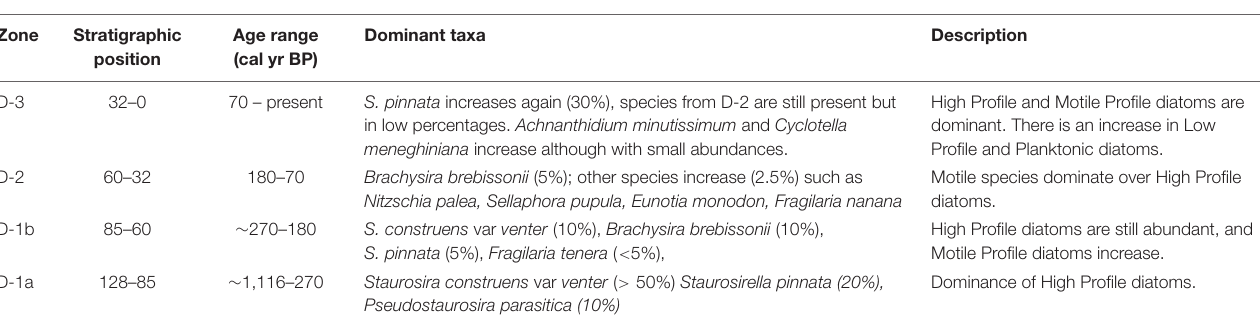
FIGURE 7 | Diatom relative abundance and functional group sums versus depth and calibrated radiocarbon age in the sediment core from Namonte, southwest Madagascar. CONISS analysis on the right side of the diagram shows the three major diatom zones, with zone D-1 divided into two subzones. TABLE 3 | Zones of Namonte diatom record. Zonation was based on the CONISS